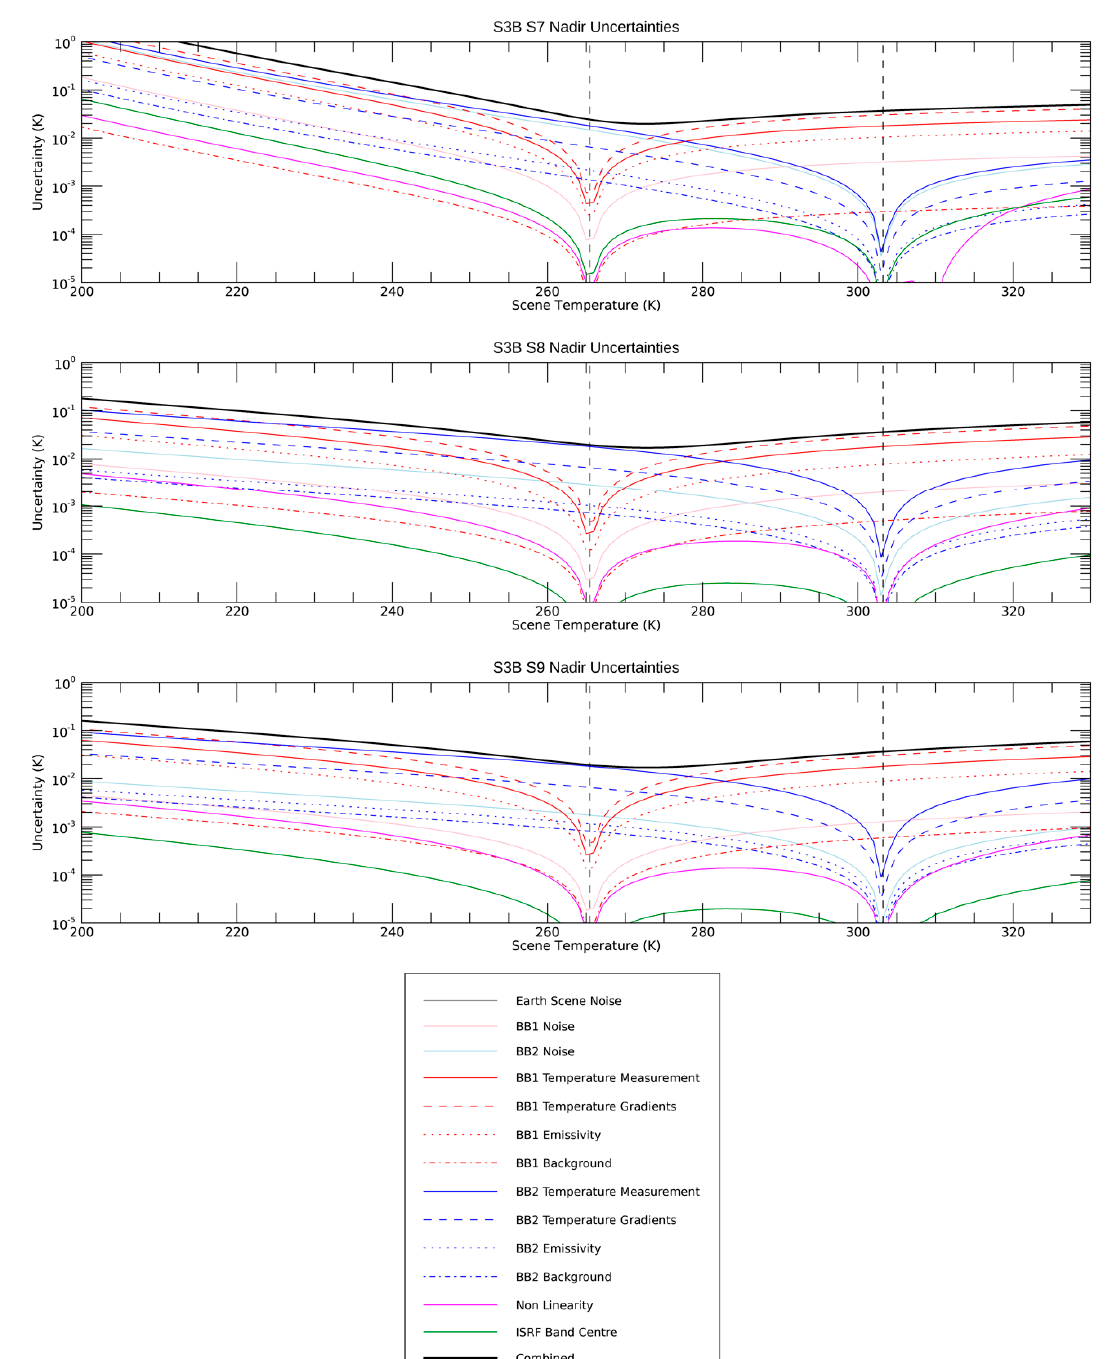
Figure 10. SLSTR-A Thermal Infrared Uncertainty Budget for a typical orbit at 1 June 2020.